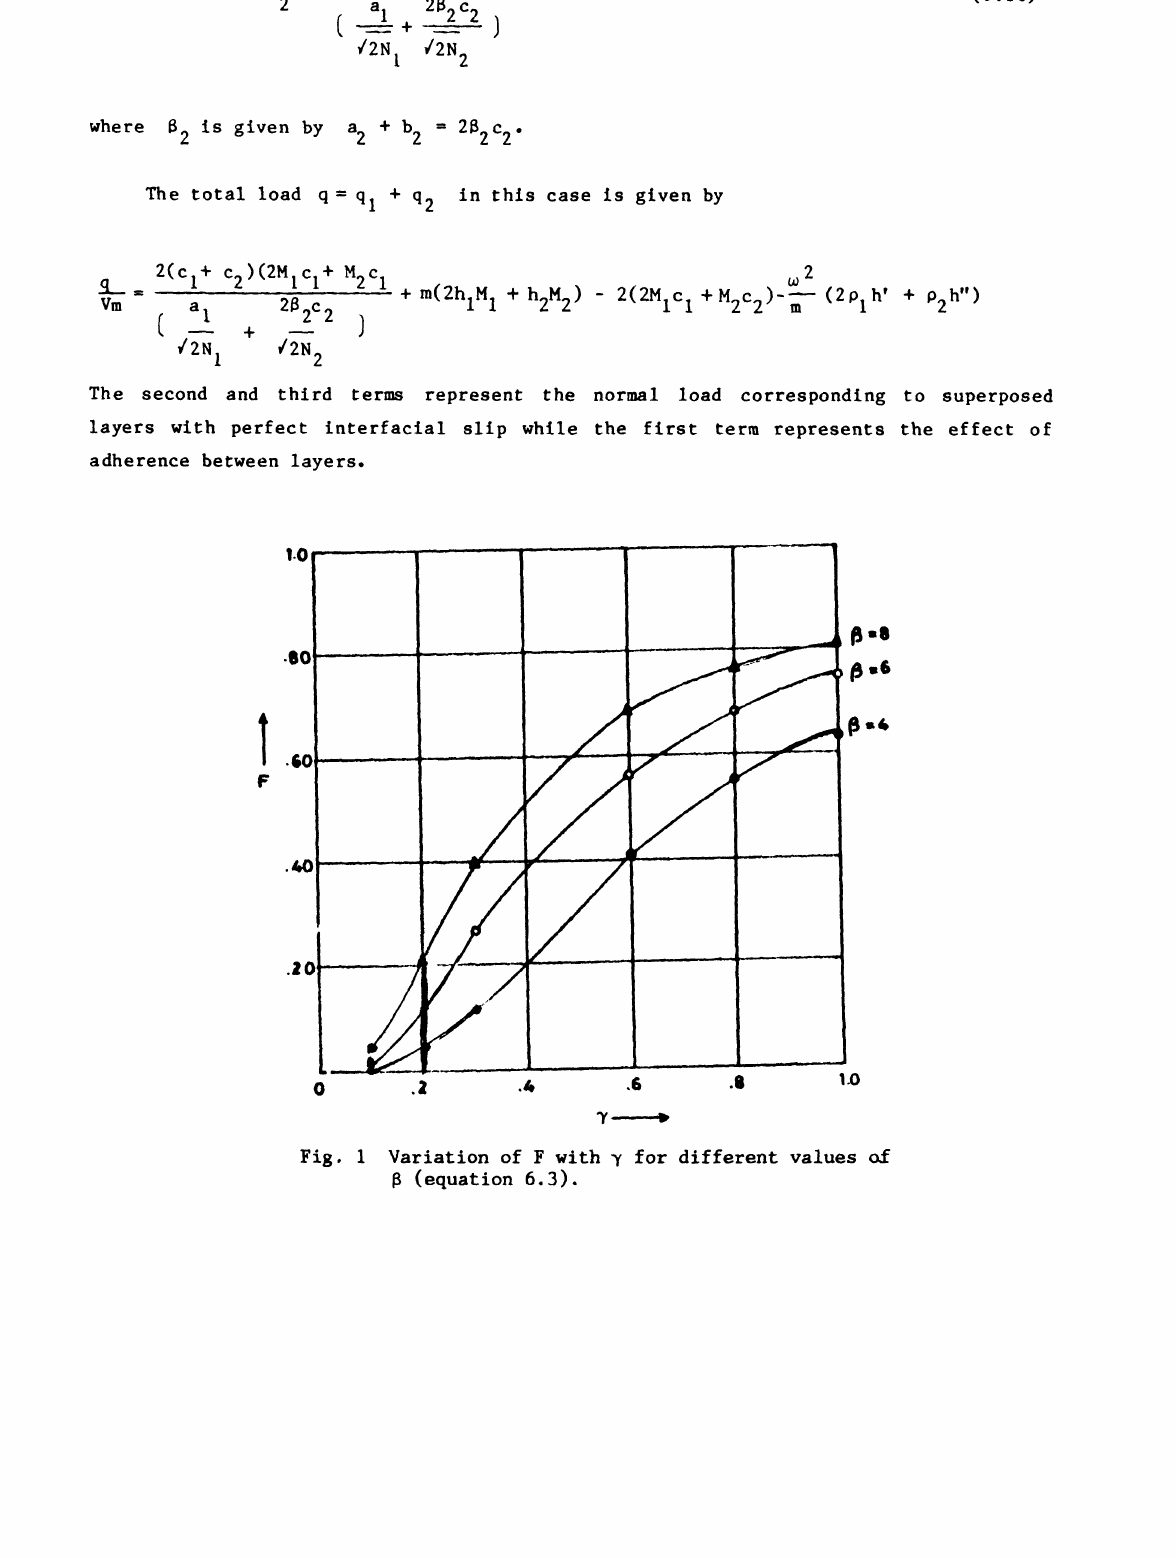
Fig. Variation of F with 7 for different values of B (equation